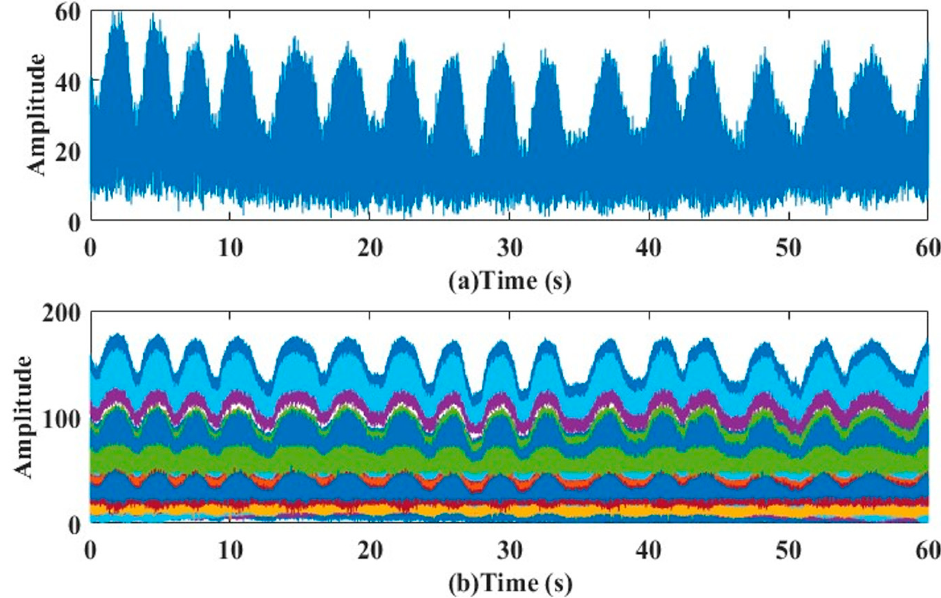
Figure 2. Breathing subcarrier sequence during sitting ( a ) one of the subcarriers; ( b ) superposition of 64 subcarriers.